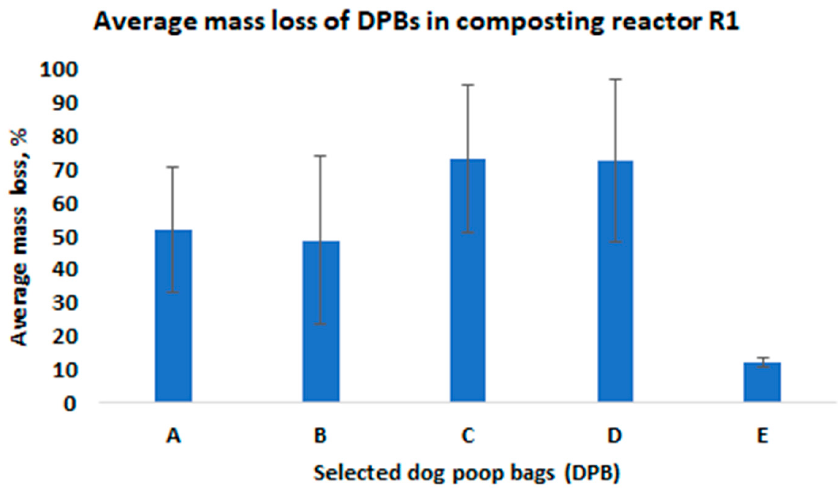
Figure 3. The average mass loss of the investigated DPBs in the composting reactor R1 after 4 weeks of composting.